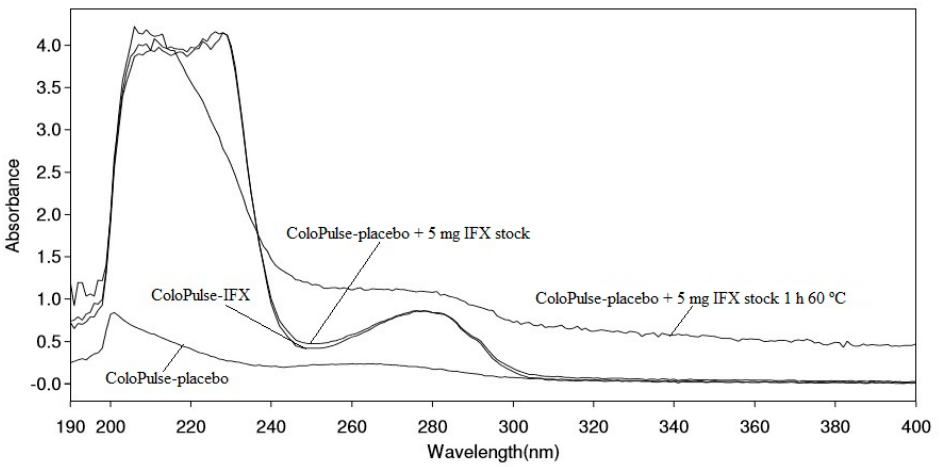
Figure 2. Representative UV-VIS spectra of ColoPulse-IFX, ColoPulse-placebo,